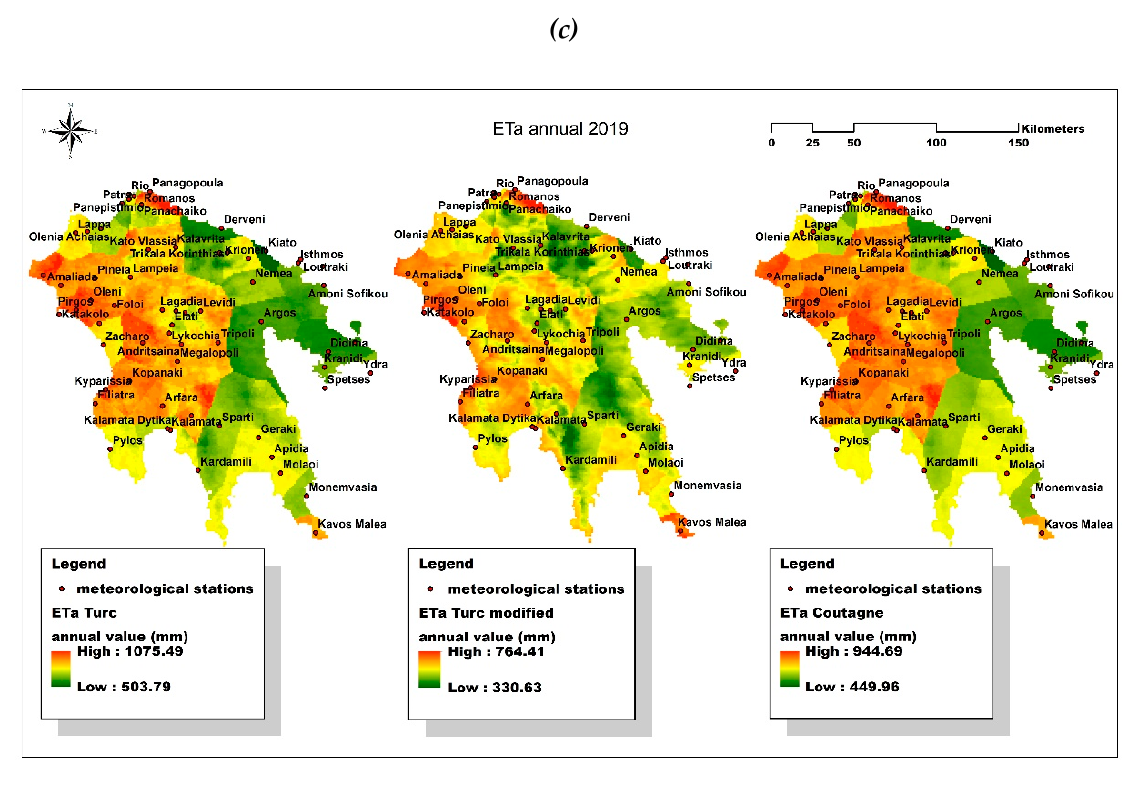
Figure 4. (a–d) Annual ETa (in mm) by empirical methods for 2016–2019, respectively. Figure 4. ( a – d ) Annual ETa (in mm) by empirical methods for 2016–2019, respectively.